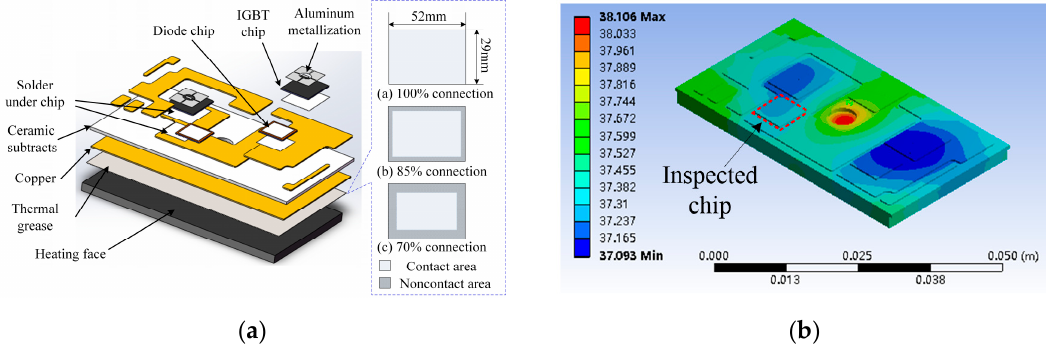
Figure 8. ( a ) Three varying degrees of thermal grease layer with different connection area and ( b ) the temperature distribution at 1 s with 100% connection area.